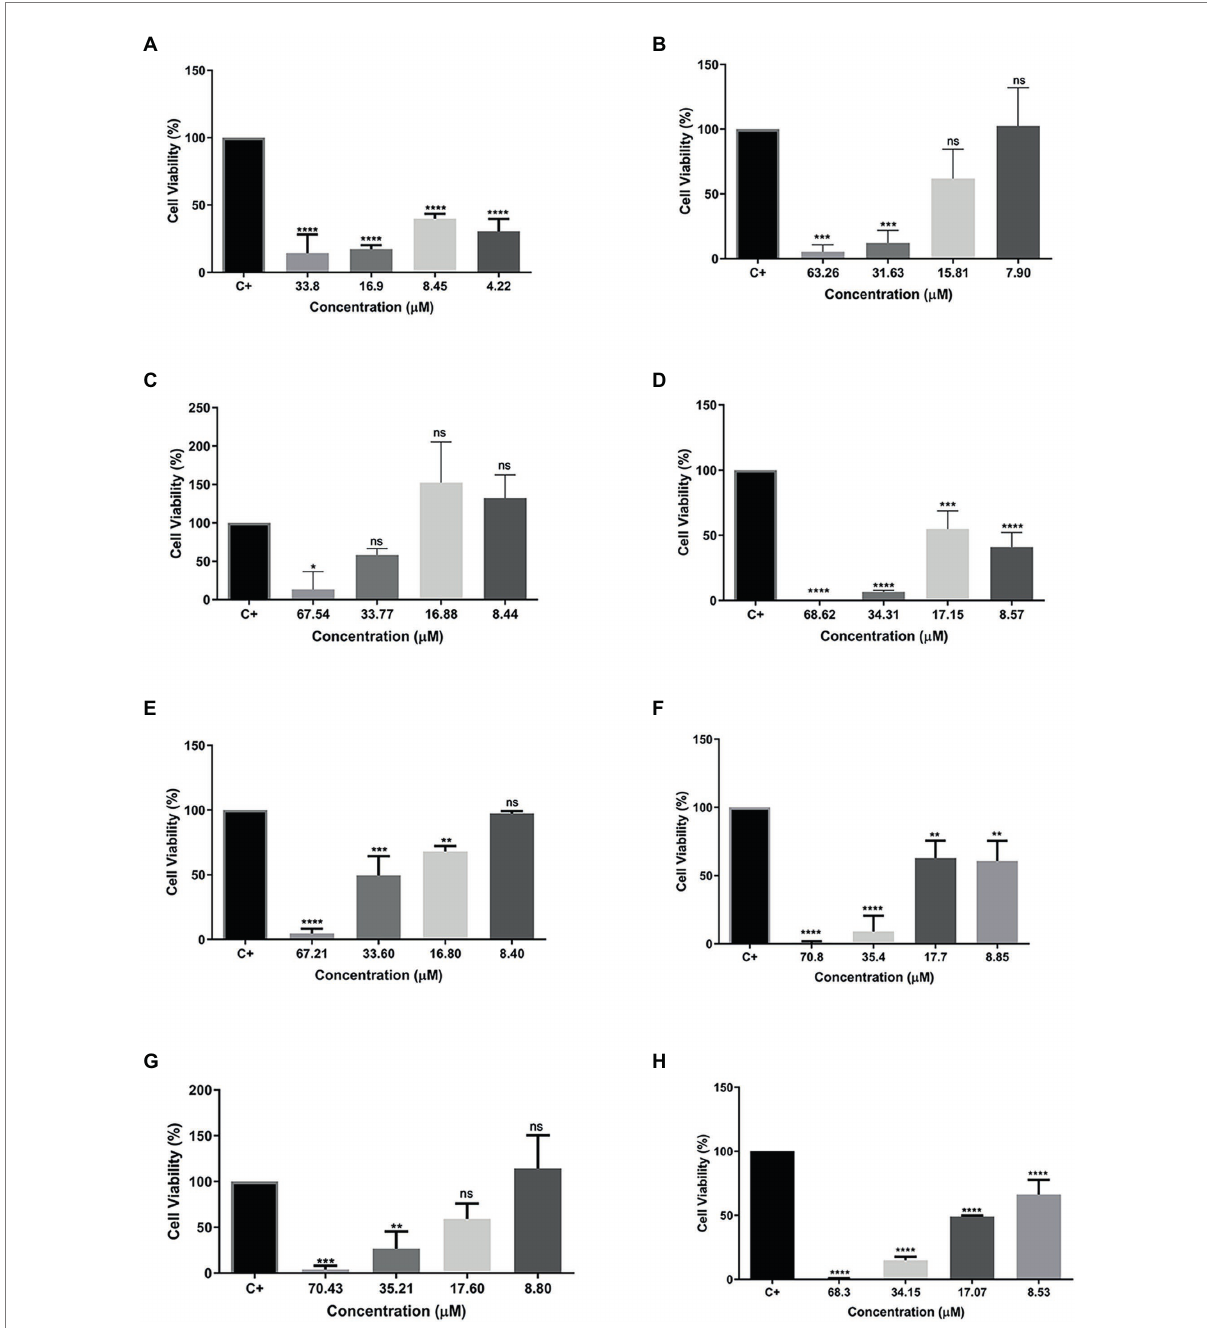
FIGURE 2 Percentage of cell viability in RAW 264.7 cells. (A) Cu-1a; (B) R1a; (C) R1b; (D) R2b; (E) R3b; (F) R6b; (G) R8b; and (H) R10b. One-way ANOVA— Bonferroni’s multiple comparisons test. Each bar represents the mean ± SD of cellular absorbance; N = 3. * p < 0.05, ** p < 0.01, *** p < 0.001, **** p < 0.0001, and NS p >